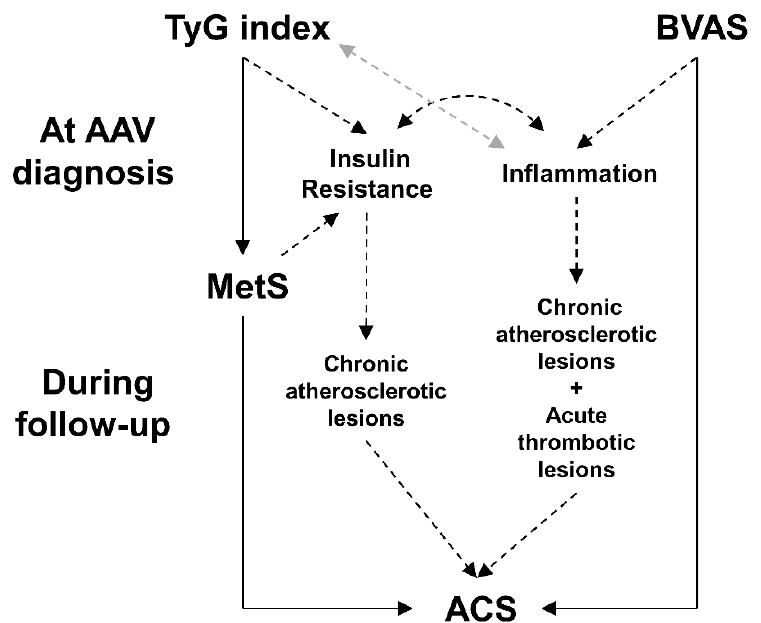
Figure 4. Overall hypotheses of a mechanism from the TyG index to ACS. Black solid arrow: the results of this study; black dotted arrow: hypothesis with high probability; grey dotted arrow: hypothesis with low probability. AAV, ANCA-associated vasculitis; ANCA, antineutrophil cytoplasmic antibody; TyG, triglyceride-glucose; MetS, metabolic syndrome; BVAS, Birmingham vasculitis activity score; ACS, acute coronary syndrome.